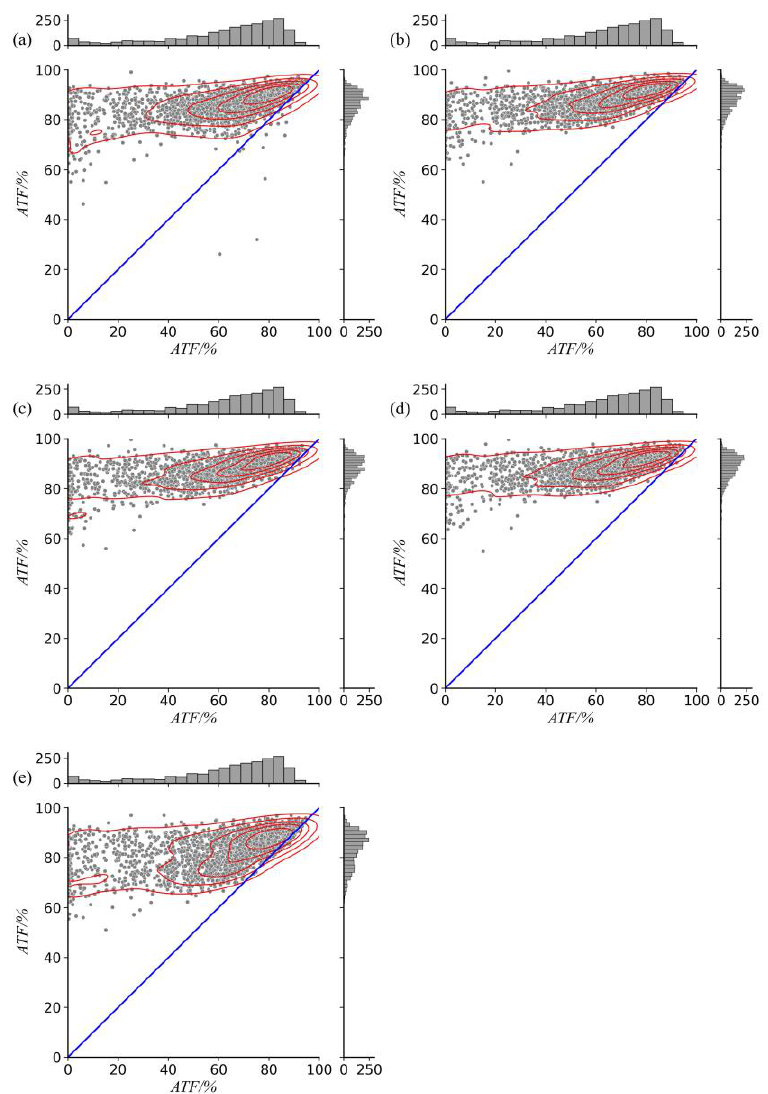
Figure 8. Bivariate of temperature forecast accuracy for ( a ) ED-FCNN, ( b ) LSTM, ( c ) TCN, ( d ) FLT and ( e ) DA model relative to the ECMWF-IFS model (horizontal coordinates are the ATF of the daily maximum temperature by the ECMWF-IFS model on the test set, vertical coordinates represent that of neural network models and DA model, red solid lines represent the contour of temperature forecast accuracy, blue solid lines are diagonal lines, the histogram at the top of the main figure is the distribution of temperature forecast accuracy of the ECMWF-IFS model, and the histogram at the right of the main figure is the frequency of temperature forecast accuracy of each neural network